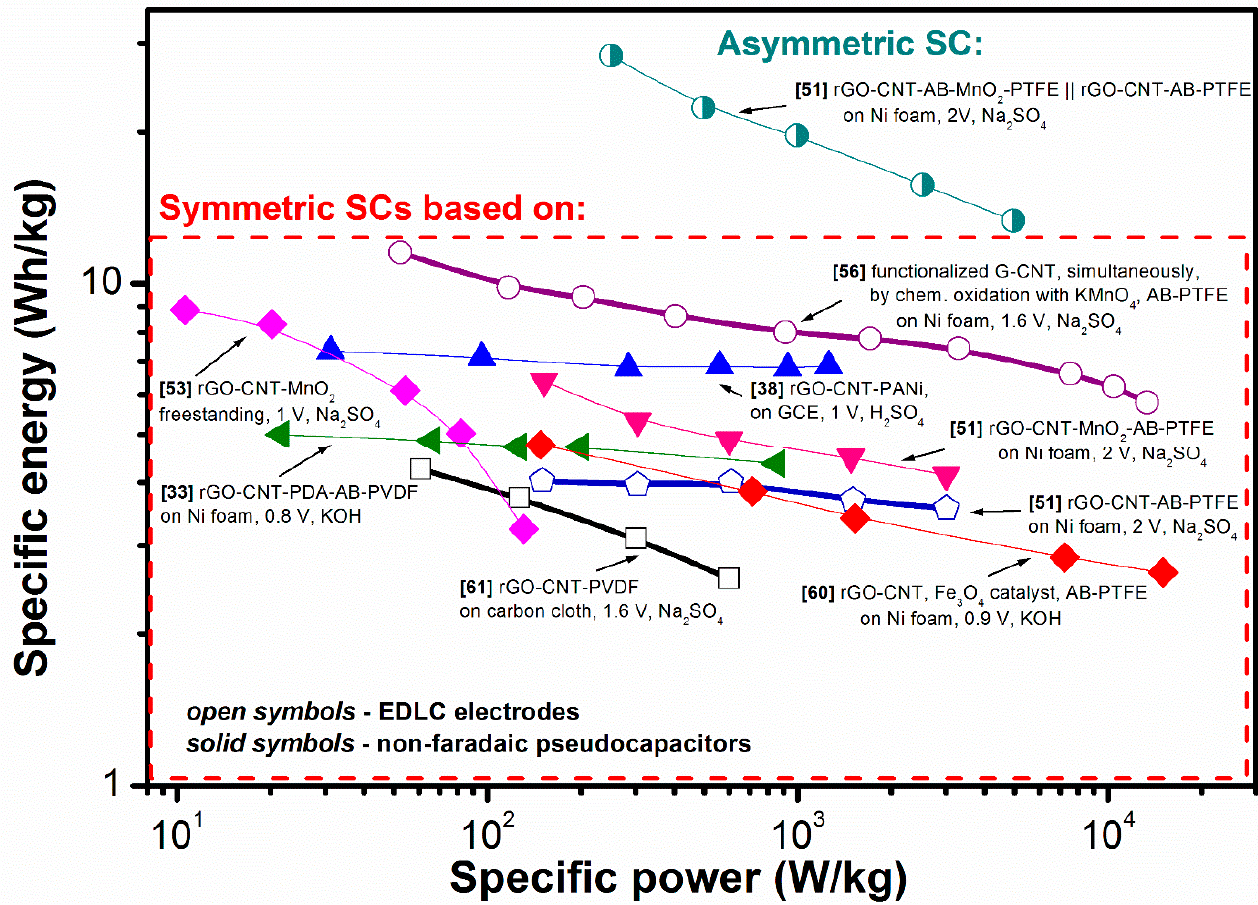
Figure 25. Ragone plots for reported energy storage devices using G/rGO-CNT-based electrodes preliminary tested in three electrode system.